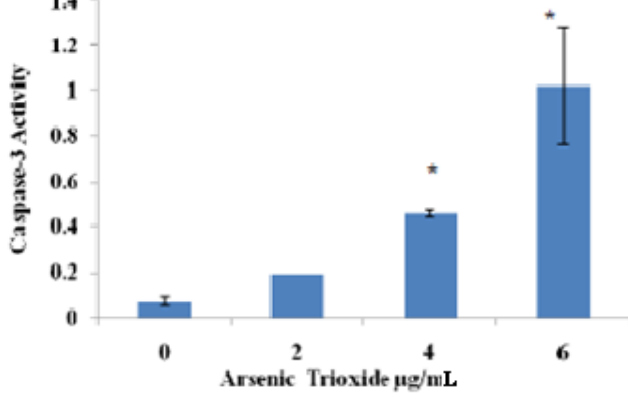
Figure 2. Effect of arsenic trioxide on caspase-3 activity in A549